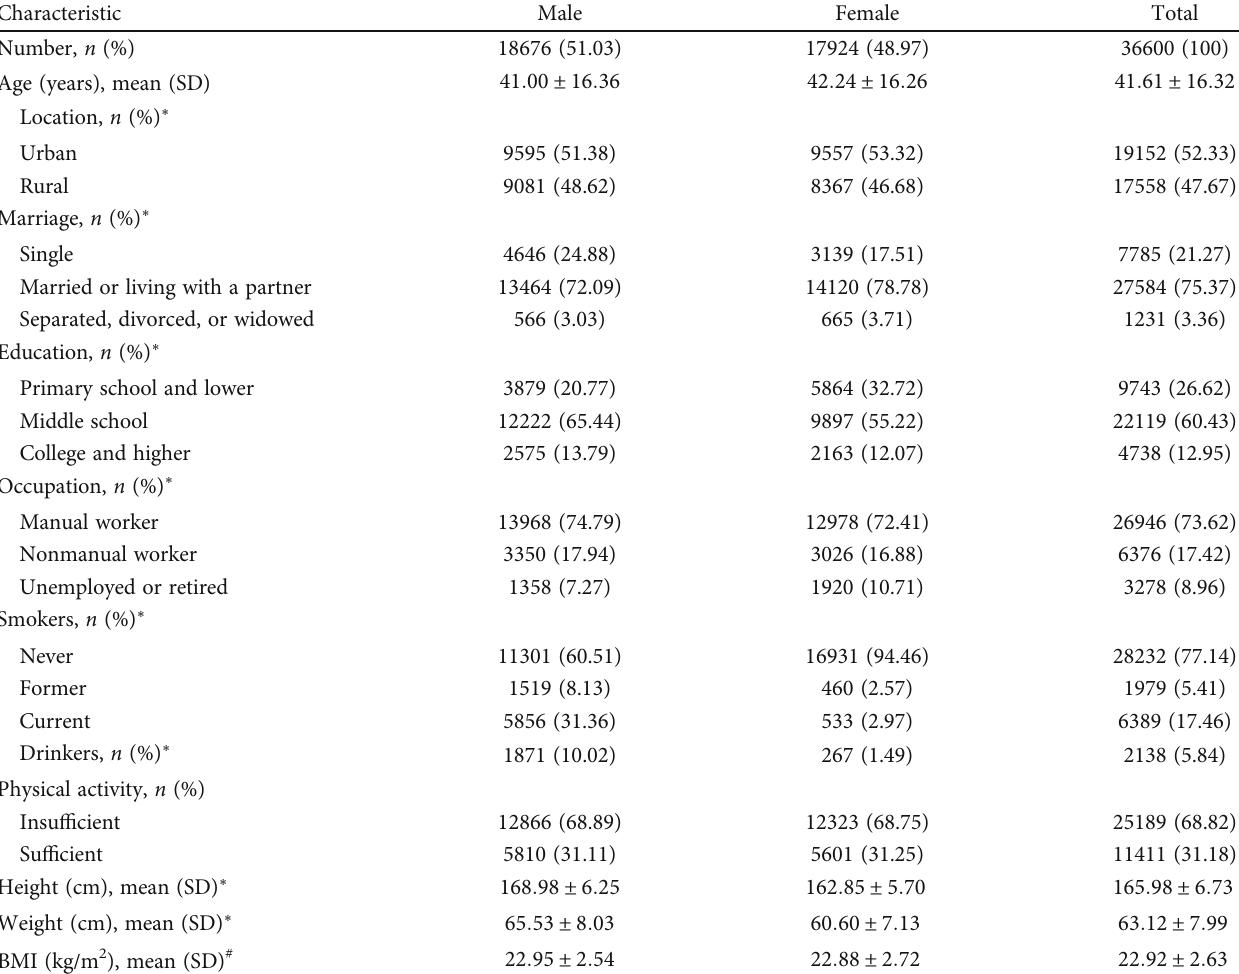
Table 1: Descriptive characteristics of participants in Baoji, western